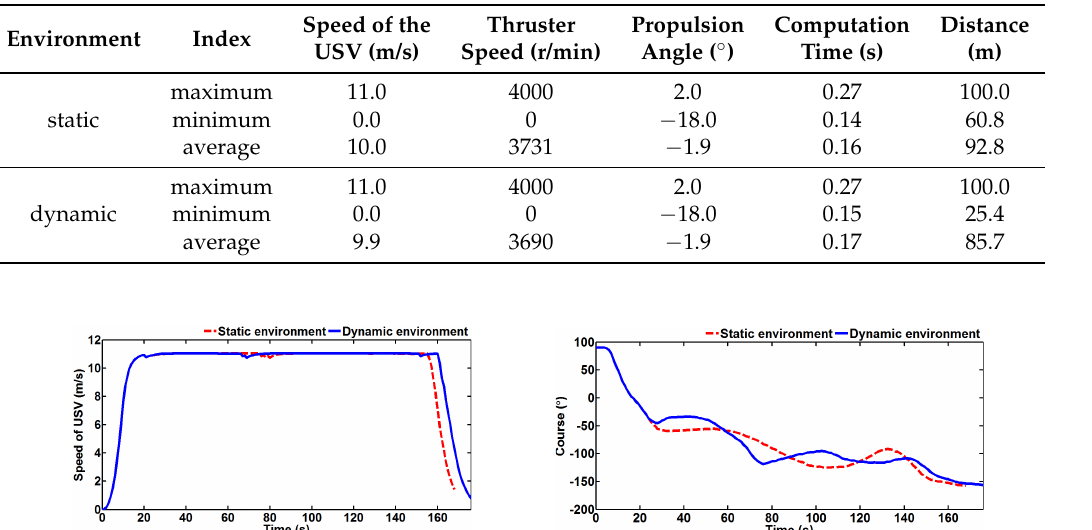
Table 3. Results of evaluation index comprised of two tests in real environment. USV: unmanned surface vehicle.